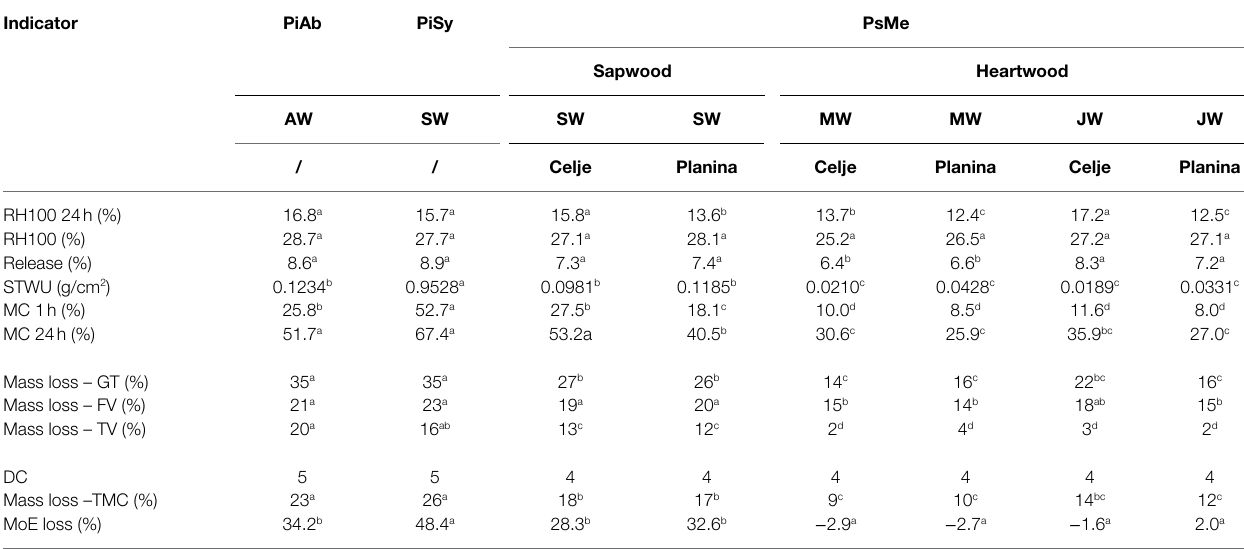
TABLE 4 | Moisture and decay indicators used to calculate factors that determine the service life of the wood.